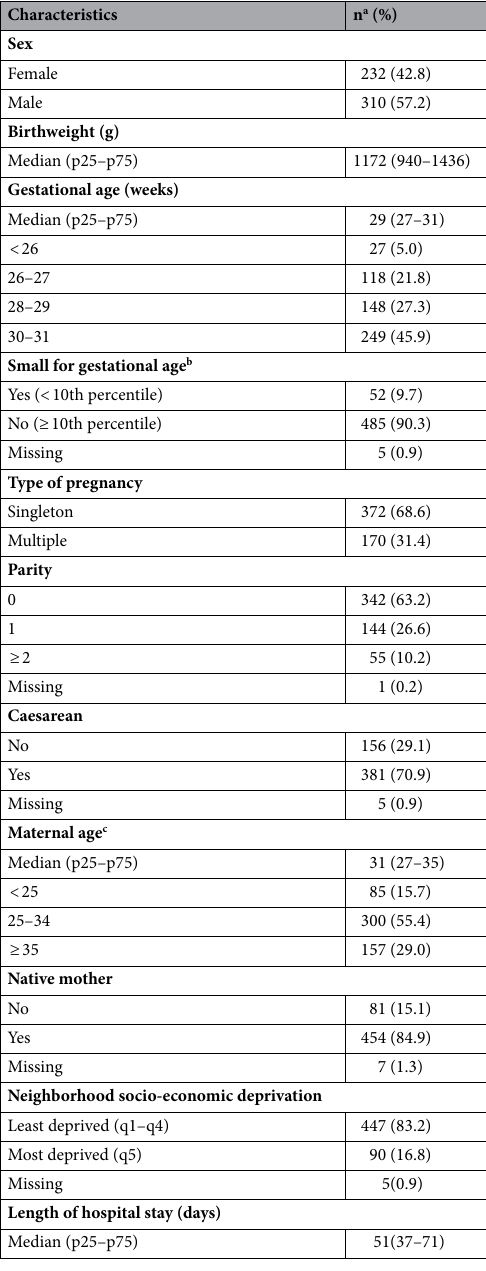
Table 1. General characteristics of the study population (n = 542). a Calculation of percentages does not include missing values. b SGA, small for gestational age, based on intrauterine curves developed for the cohort 54 . c The sum of the categories surpasses 100% as the numbers were rounded